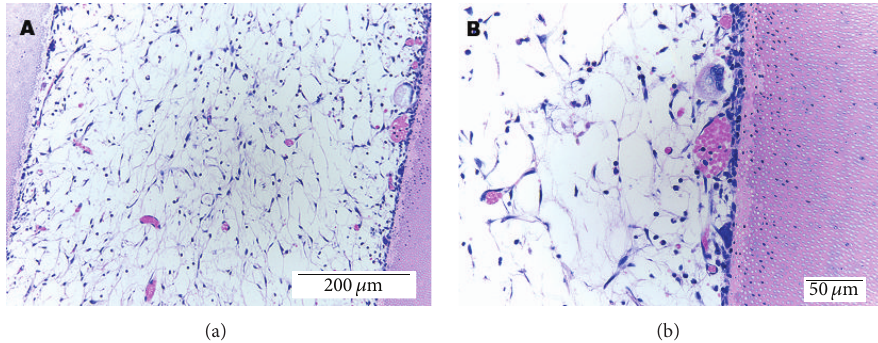
Figure1:DentalpulptissueengineeredbythetransplantationofSHEDloadedinaninjectablescaffold(a)andtoothextractedfororthodontic reasons (b). Reprinted with permission from [11] (Copyright (2011) John Wiley and